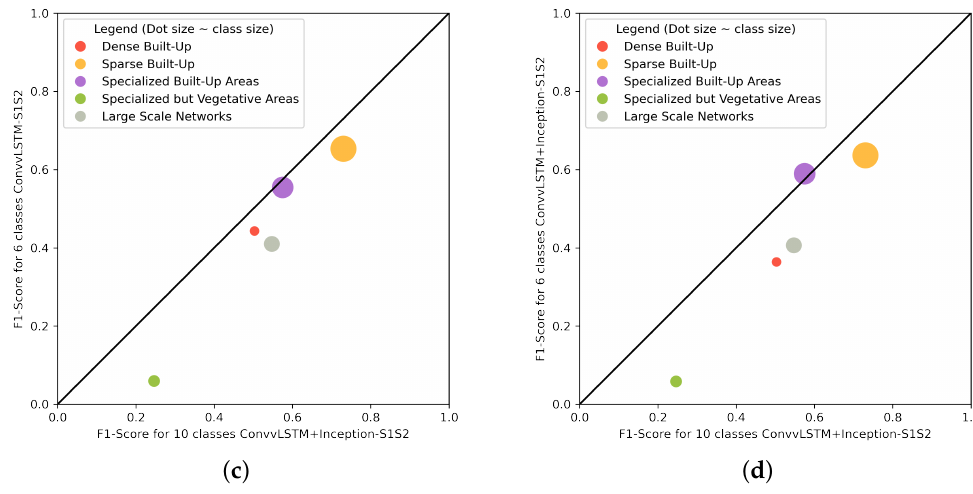
Figure 10. Scatter plot to compare UFs (classes 1 to 5 in Table 3) classifications of ConvLSTM+ Inception-S1S2 for 10 classes between every method implemented for 6 classes. ( a ) 10 classes vs. 6 classes ConvLSTM-S2. ( c ) 10 classes ConvLSTM+Inception-S1S2 vs. 6 classes